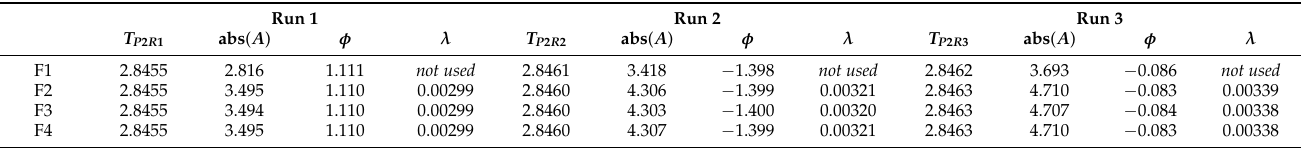
Table 5. Results for the oscillation around P2 for the four different functions to calculate the period T , initial amplitude A , phase angle φ and decay constant λ for three different runs (repeats)—offset for F4 is − 0.014, − 0.014 and − 0.007 ◦ . Run 1 Run